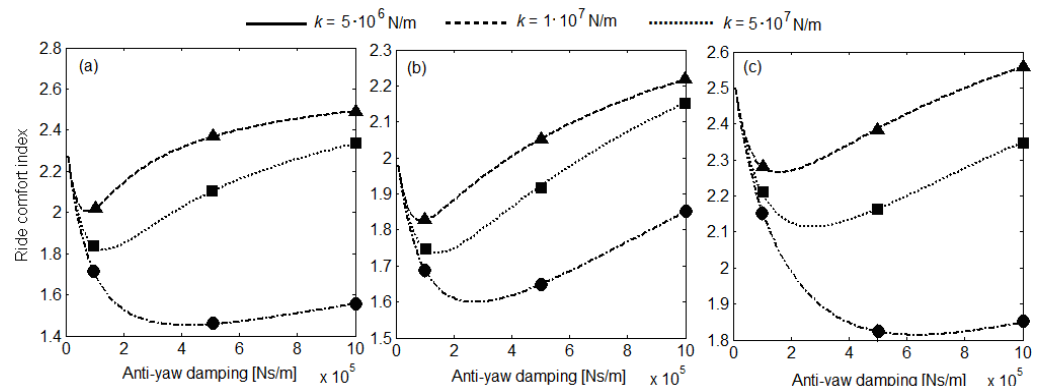
Figure 14. Influence of the anti-yaw damping upon the ride comfort index at a velocity of 300 km/h: ( a ) at carbody center; ( b ) against the front bogie; ( c ) against the rear bogie.